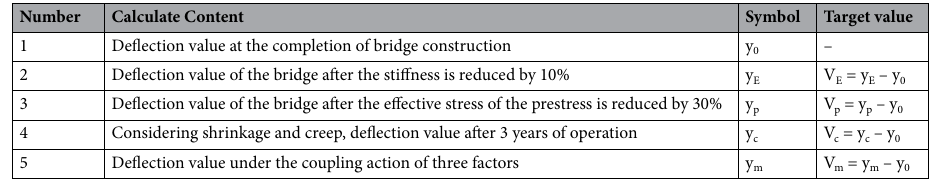
Table 1. List of calculation